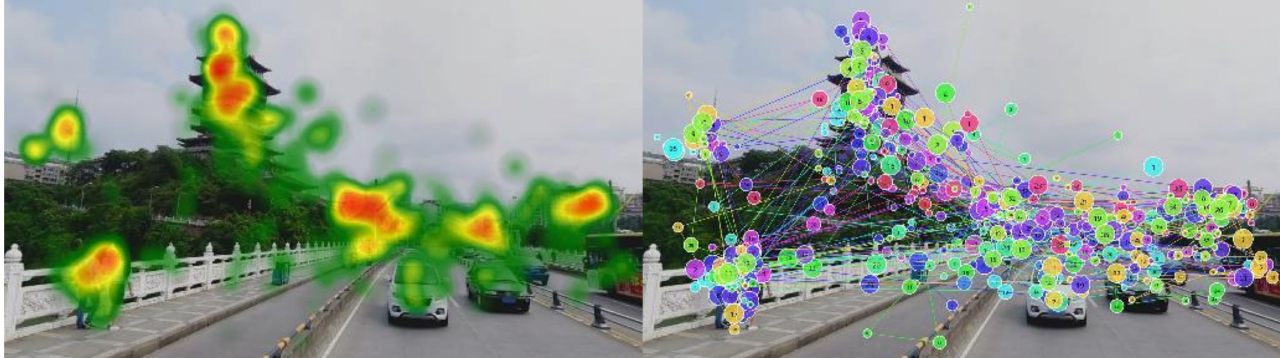
Figure 3. An example picture showing a heat map ( left ) and track map ( right ). The heat map shows the different distribution of the participants’ fixation, and the darker the color, the longer the fixation time. The track map shows the movement of the participants’ fixation track, and the circle represents the location of the fixation point, and the numbers inside represent the order of